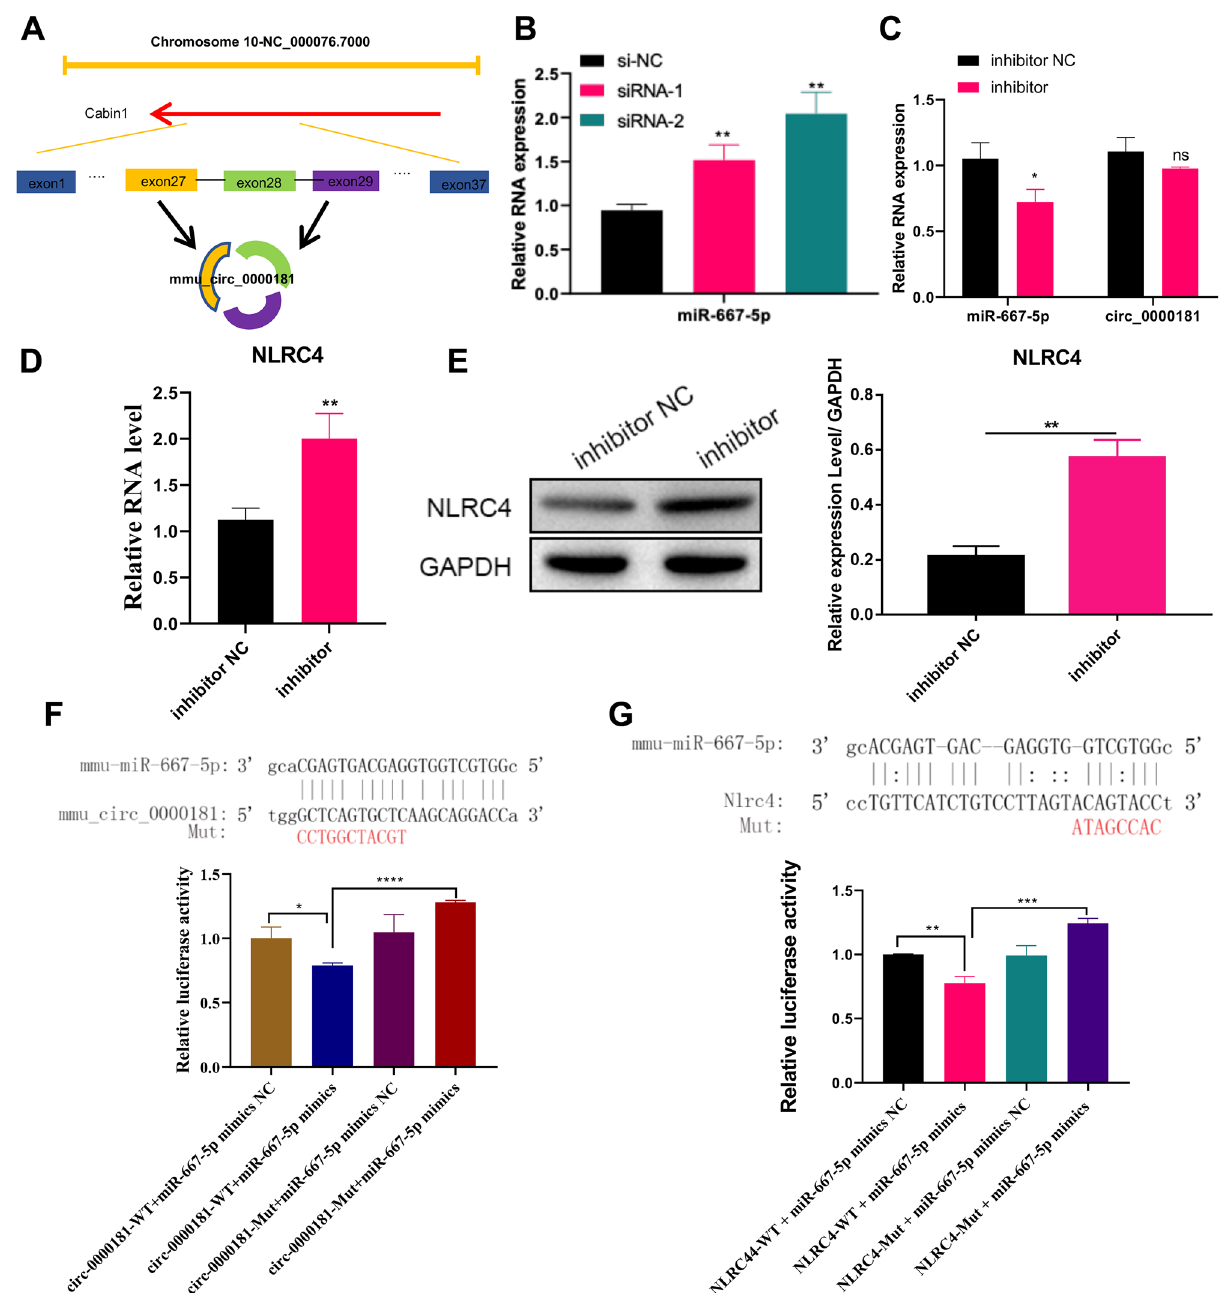
Figure 5. circ_0000181 regulates the miR-667-5p/NLRC4 Axis in MRTEC cells. ( A ) Schematic diagram of shear composition of circ_0000181. ( B ) qPCR analysis was used to measure circ_0000181 and miR-667-5p expression in MRTEC cells under different circ_0000181 interference fragments. ( C ) qPCR analysis was used to evaluate circ_0000181 and miR-667-5p expression in MRTEC cells under miR-667-5p inhibitors interference. (D&E) qPCR ( D ) and WB ( E ) analyses were used to test NLRC4 expression in MRTEC cells under miR-667-5p inhibitor interference. The origianl images were cut prior to hybridisation with antibodies during blotting. ( F ) The prediction binding site of circ_0000181 and miR-667-5p was confirmed using dual-luciferase assay. ( G ) The prediction binding site of miR-667-5p and NLRC4 was confirmed using dual-luciferase assay. * P < 0.05; ** P < 0.01; *** P < 0.001; **** P < 0.0001. Data are presented as the means ± SD from three independent